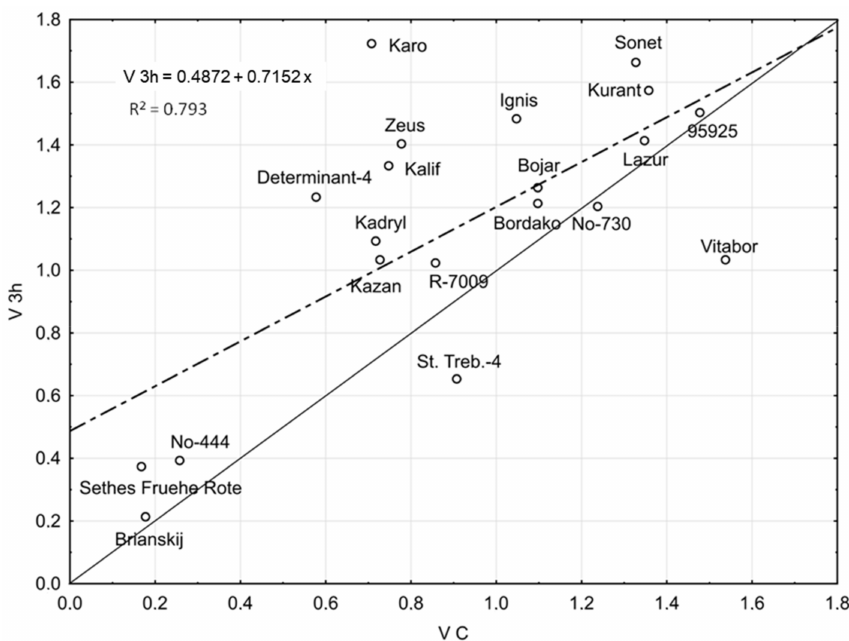
Figure 2. Seed germination vigour (V) of Lupinus angustifolius lines/cultivars at 7 ◦ C after 3-h hydropriming (V 3 h) vs. control (V C). Dashed line indicates the regression line. Solid line separates lines/cultivars according to their response to 3-h hydropriming: points lying above and below the line correspond to more- and less-responsive line/cultivars,